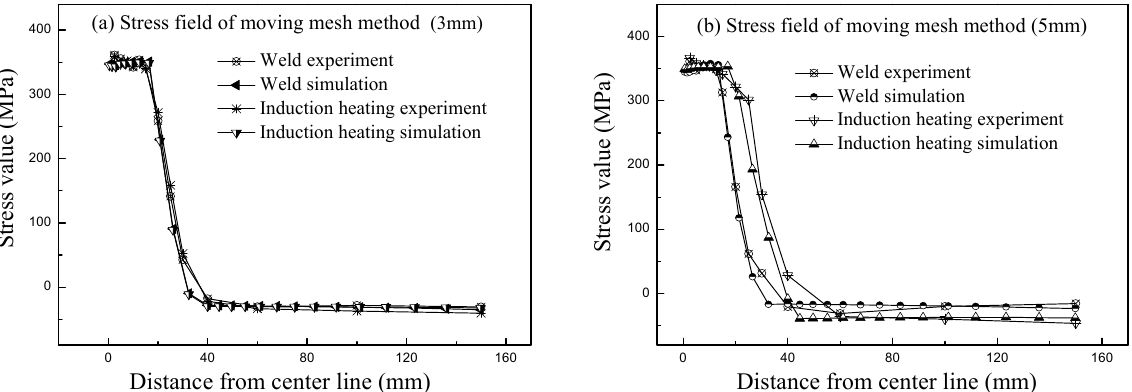
Figure 12. Comparison of the deformation between moving mesh method model and experiment. ( a ) 3 mm, ( b ) 5 mm.